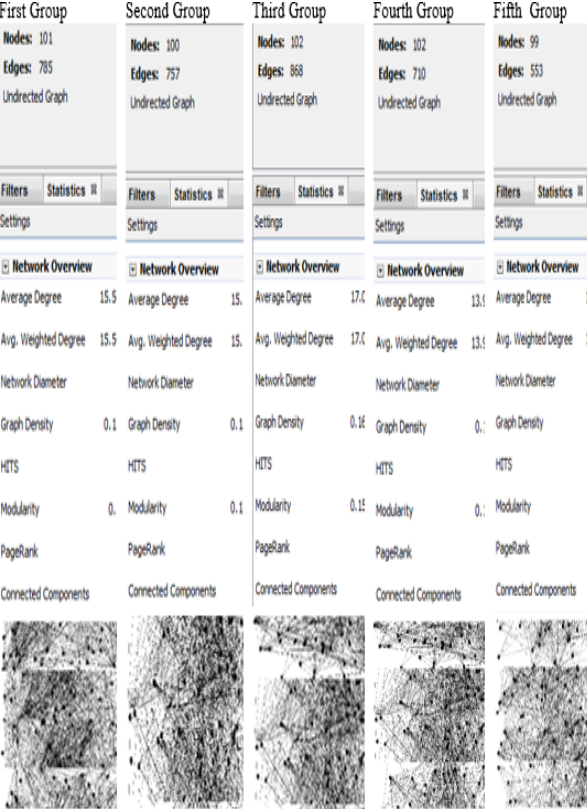
Figure 8. Full view of network graph after grouping.